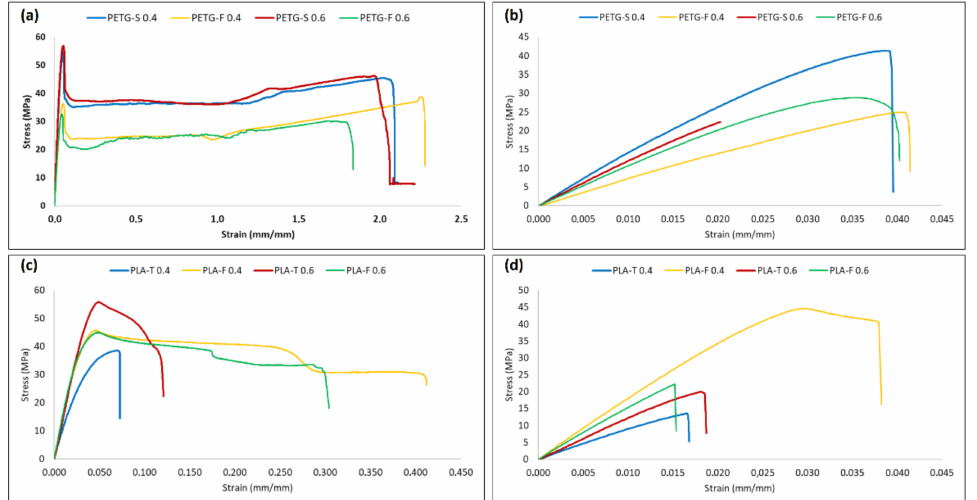
Figure 5. Stress–strain curves for PETG and PLA samples in (1,0,0) ( a , c ) and (0,0,1) ( b , d )